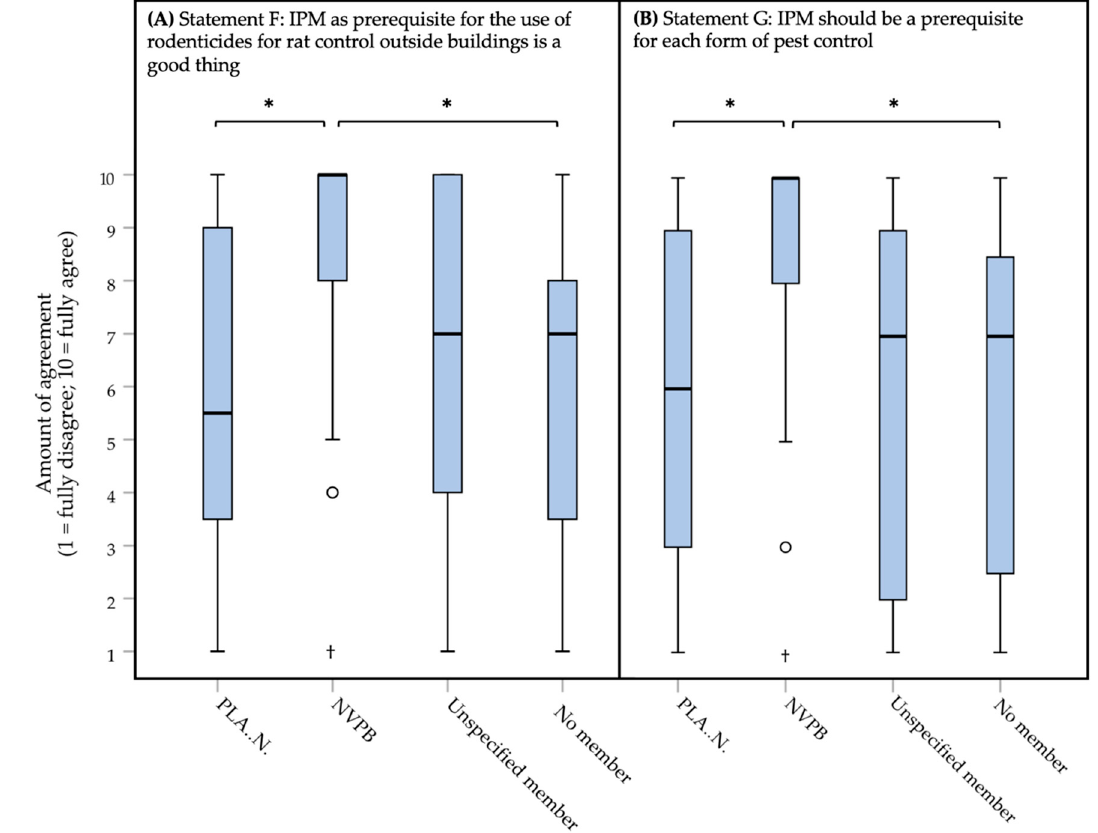
Figure 2. Box plots presenting the amount of agreement with three statements (panel ( A ): statement F; panel ( B ): statement G) about the general attitudes of IPM (Integrated Pest Management). Amount of agreement could be indicated on a 1 (fully disagree) to 10 (fully agree) interval rating scale. Data were obtained through an online survey among the total 129 Dutch pest controllers about the treatment of rats ( Rattus rattus and Rattus norvegicus ) and mice ( Mus musculus ). Outliers and extreme cases are indicated with o and † , respectively. Statistically significant di ff erences between two types of membership (PLA..N.: n = 40; NVPB: n = 35; Unspecified member: n = 19; No member: n = 35) are indicated with * for each of the panels ( A ) and ( B ).